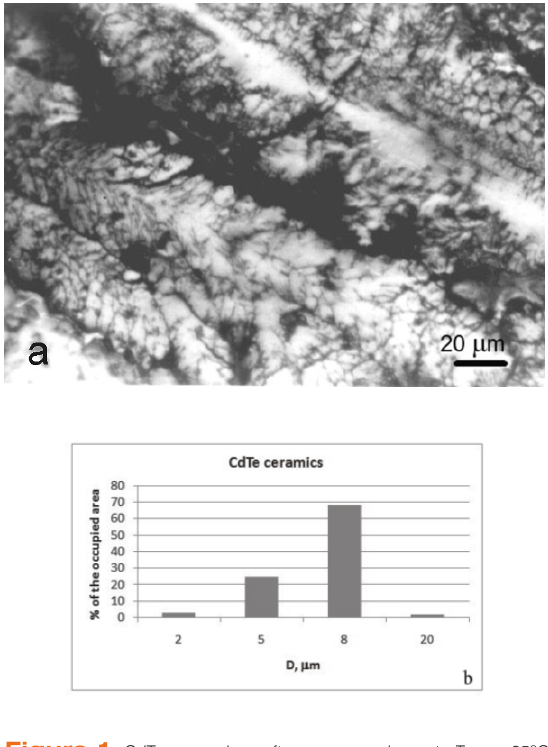
Figure 1. CdTe ceramics after compression at T = 25ºC, p = 600 MPa: (a) microstructure; (b) grain size distribution.